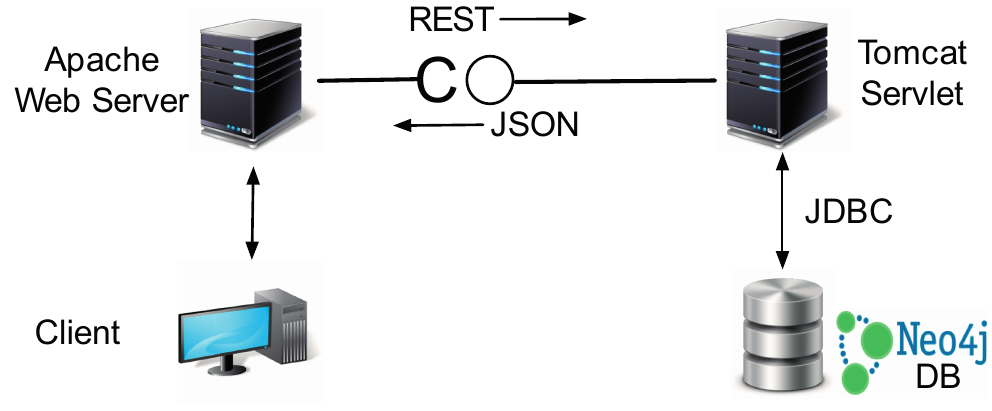
Figure 5. Communication between frontend and